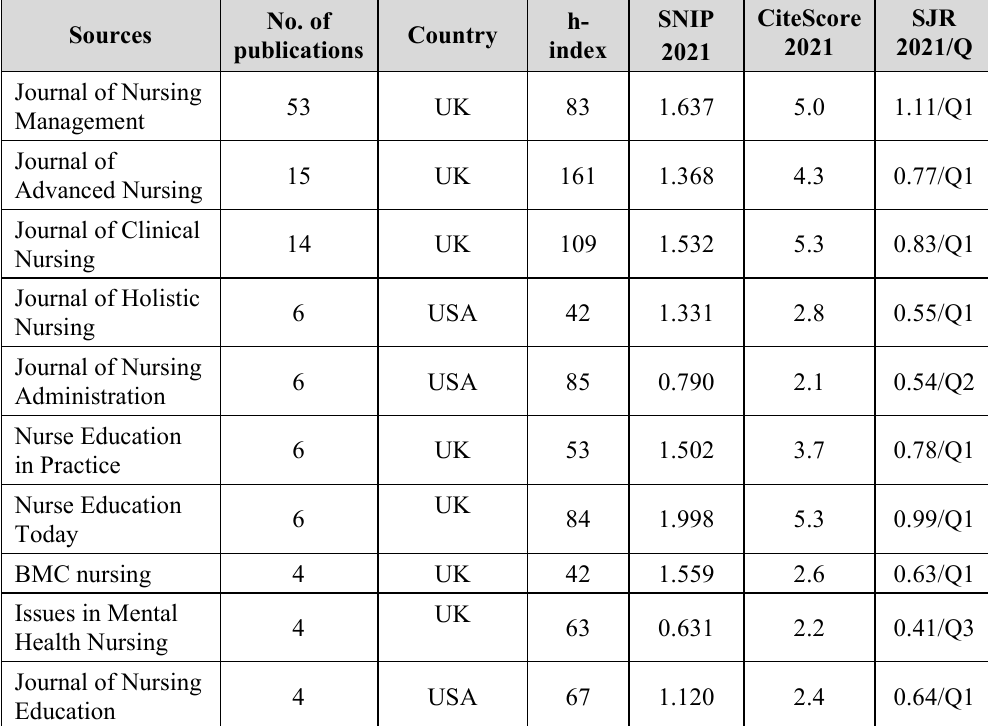
Table 4. The Most Productive Sources, 2005–2022 (up to 7